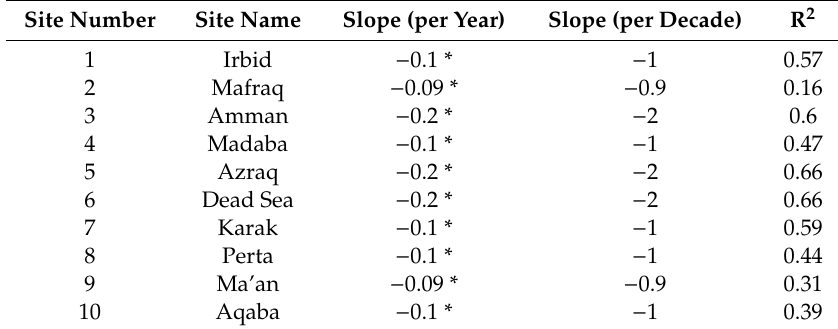
Table 5. Mann–Kendal trend test predicted by Sen’s slope estimator for yearly mean relative humidity during